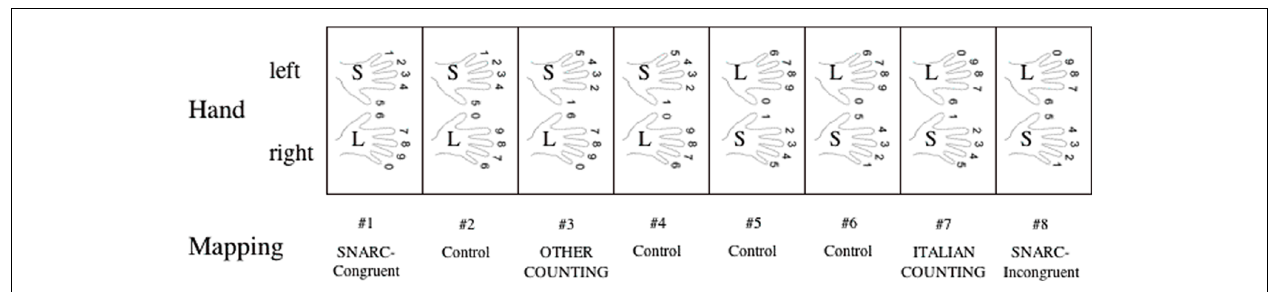
FIGURE 2 |The various finger-digit mappings tested in Di Luca etal.